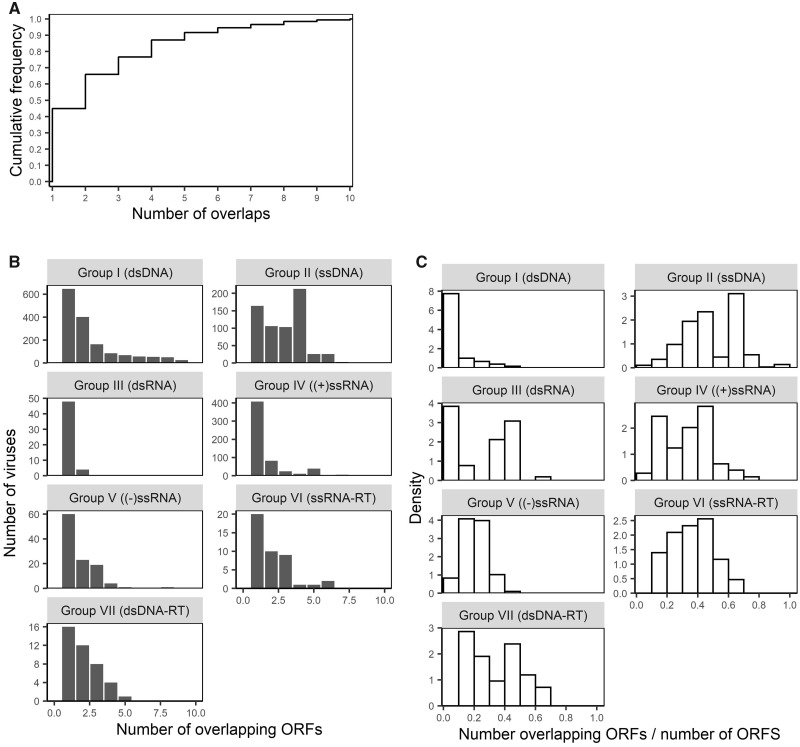
(A) The cumulative distribution of the total abundance of gene overlap (number of gene with an overlap per genome) over all viruses studied here. (B) Histograms of the total abundance of gene overlap by virus family, truncated at 10. All virus groups had a maximum total abundance less than or equal to 10, except dsDNA viruses with a very long tail up to 789, and ssDNA viruses with a maximum of 15. (C) Histograms of the total abundance of gene overlap by family as a proportion of the number of genes (relative frequency = number genes with an overlaps/number of genes).